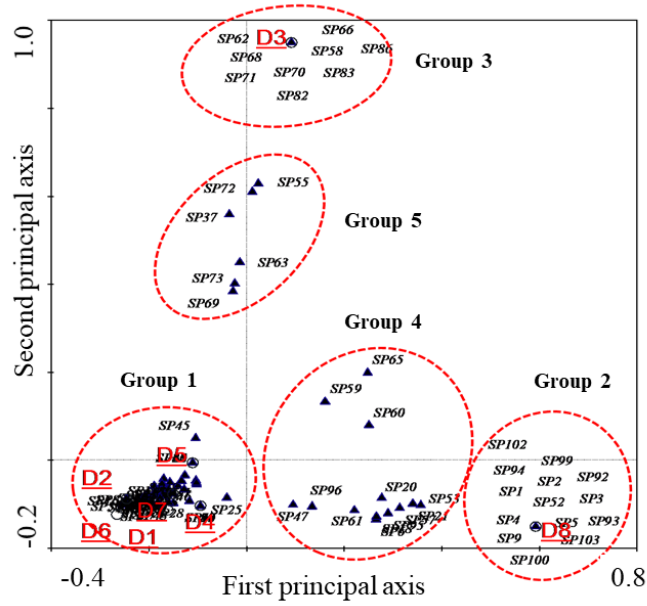
Figure 7. Biplot of species scores and habitats in a CCA of treatment systems acclimatized with different azo dyes. D1–D8 show the bacterial community structure of sludge acclimatized with various dyes (as mentioned above). Black triangles are presenting the specie and red circles were added to highlight different groups. Full names of species are presented in Table S5.